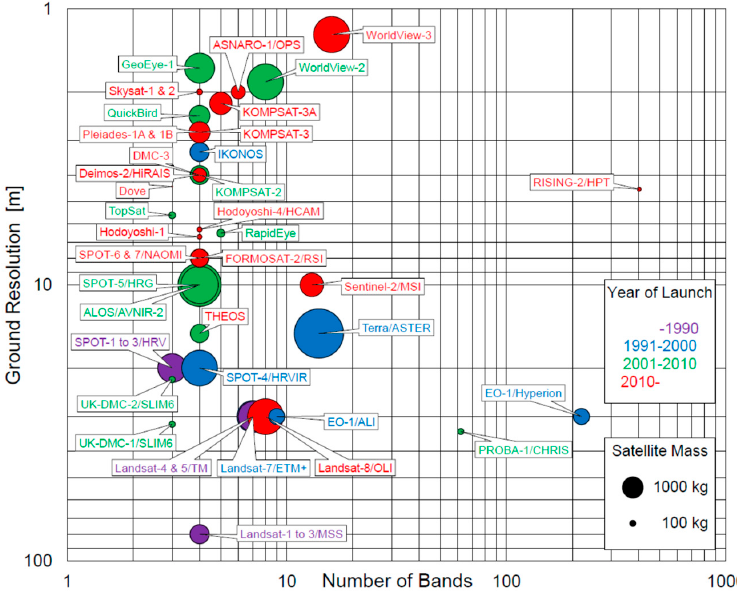
Figure 1. Diagram of the high and moderate spatial resolution multispectral Earth observation satellites/sensors launched in the past. satellites/sensors launched in the